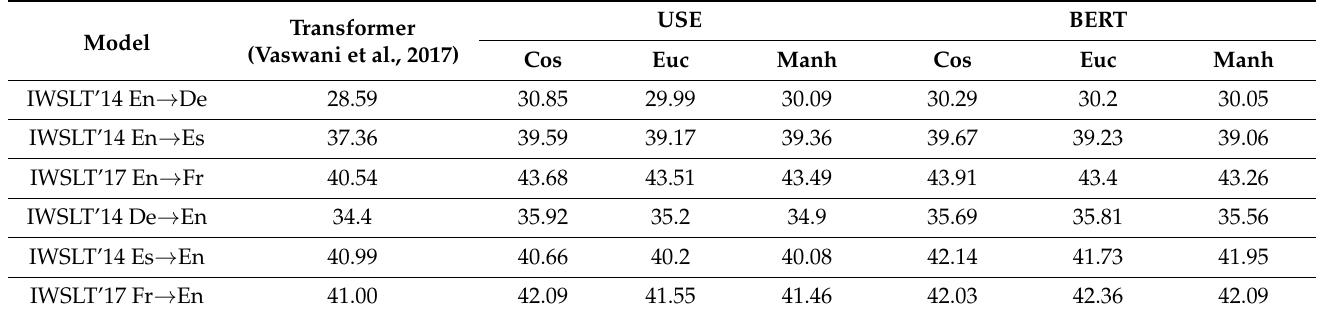
Table 4. BLEU scores of the models. Best embedding and similarity measure for each model. “Cos”, “Euc”, and “Manh” indicate the cosine similarity method, Euclidean distance, and Manhattan distance, respectively.